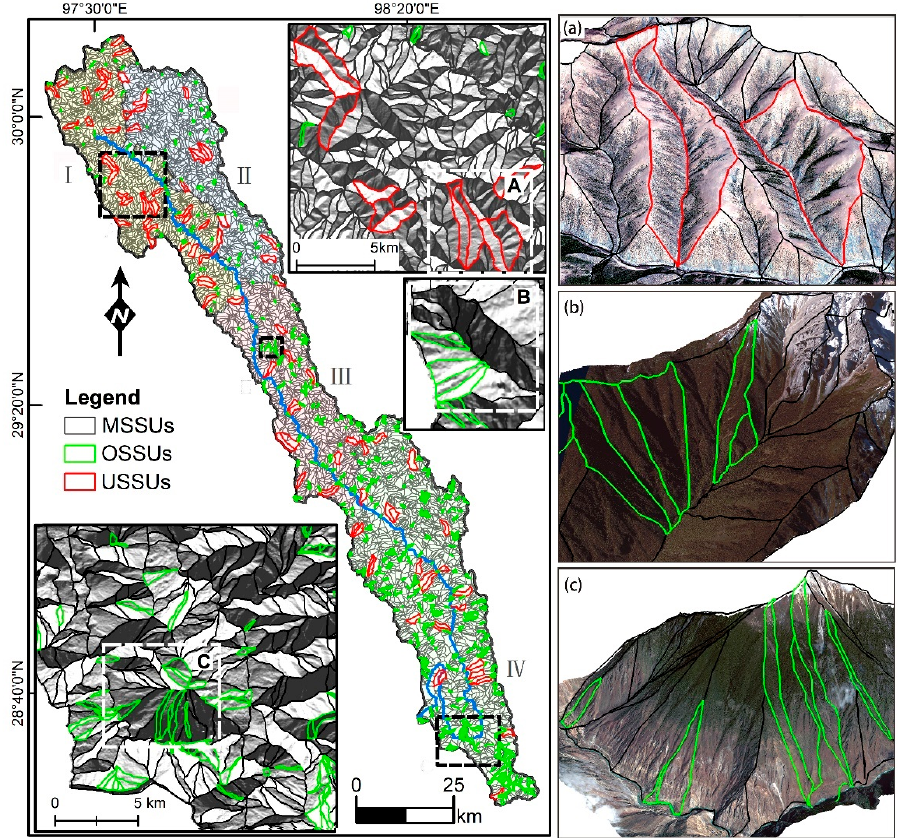
Figure 8. Left is the map of spatial distribution of MSSUs, USSUs and OSSUs in the Yuqu River